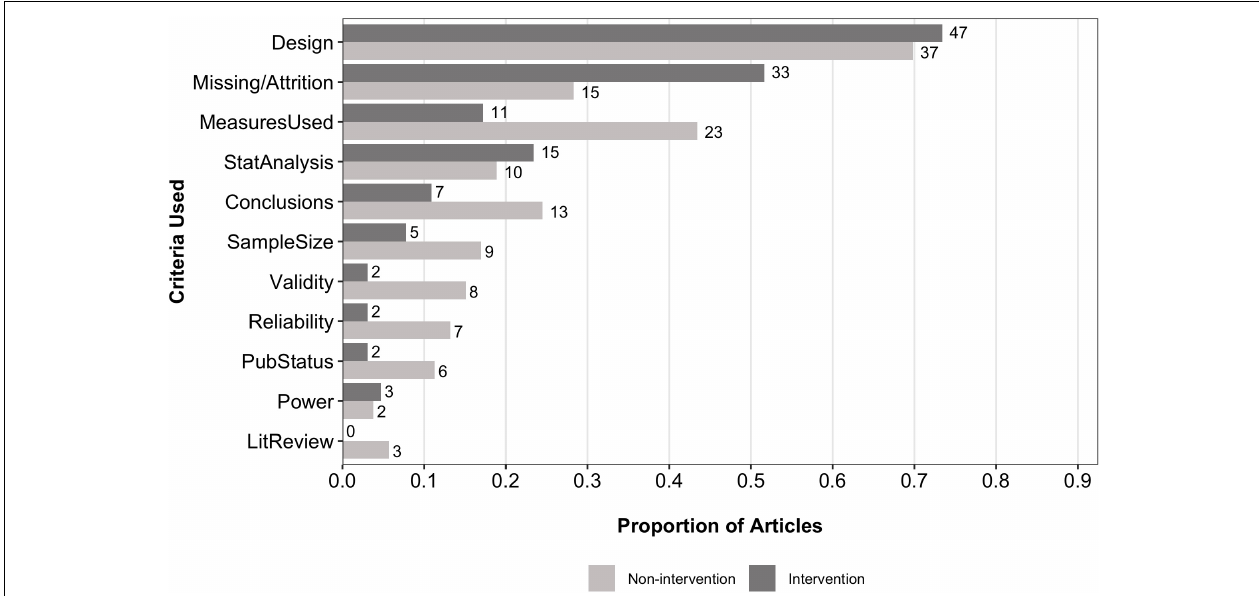
FIGURE 5 | Comparison of criteria used to judge PSQ between intervention and non-intervention meta-analyses. Data source: QUASR-R coding. Conclusions, adequacy of conclusions drawn in the individual primary studies; Design, study design of the individual primary studies; LitReview, literature review; MeasuresUsed, measures used in the individual primary studies; Missing/Attrition, missing data or attrition rates in the individual primary studies; PubStatus, publication status; StatAnalysis, statistical analyses used in the individual primary studies. Sample sizes for intervention and non-intervention groups were 64 and 53, respectively. Because articles were coded for multiple criteria, proportions do not sum to 1.